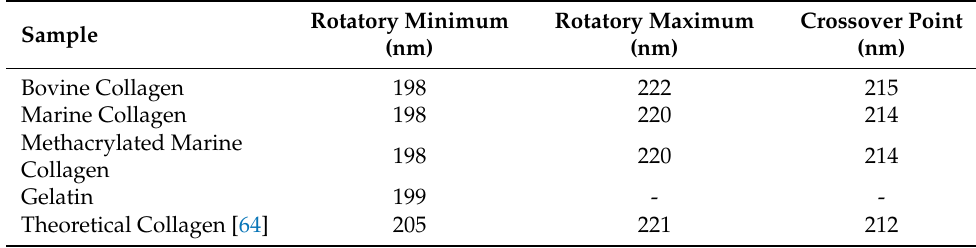
Figure 3. Circular dichroism spectra, taken at 5 °C. All samples were dissolved in 20 mM acetic acid and diluted to a final concentration of 0.3 mg/mL. Table 1. CD data for the extracted marine collagen, compared with commercial bovine collagen and gelatin. The theoretical values are also